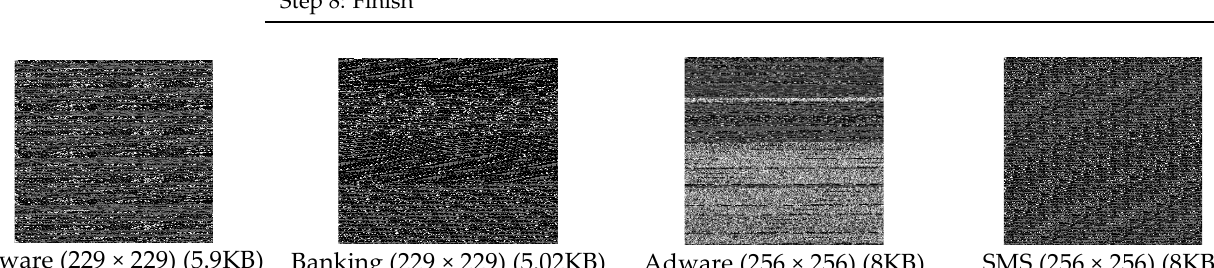
Figure 4. A chunk of malware images (229 × 229, 256 × 256) extracted from network traffic. Algorithm 3: Texture Feature Mining